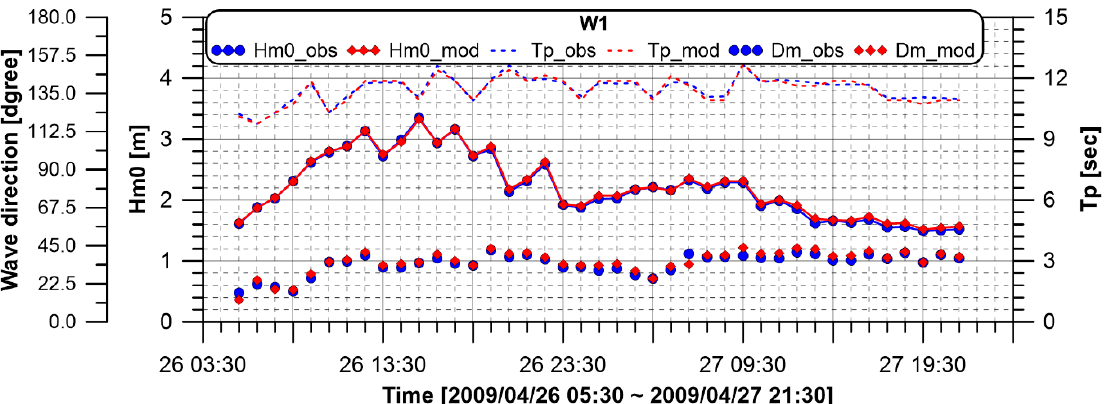
Figure 12. Comparison of wave conditions ( H m 0 , T p , and D p ) between the observational (blue) and modeled (red) data in W1 during the period of the wave event selected for BC from 05:30 on the 26th to 21:30 on 27 April 2009 (39 h). It is noted that the modeled data matched well with the observational data due to the proximity of W1 to the open boundary, as shown in the computational domain (Figure 4b).